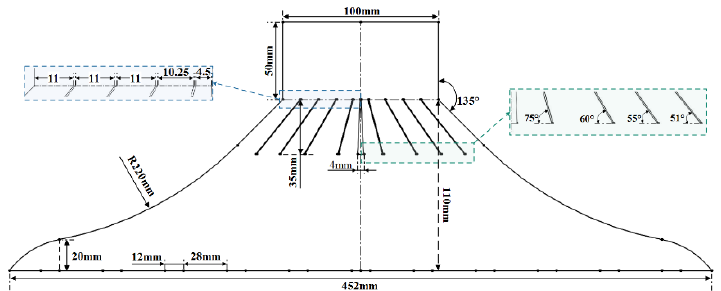
Figure 14. Optimum configuration of improved inlet header.